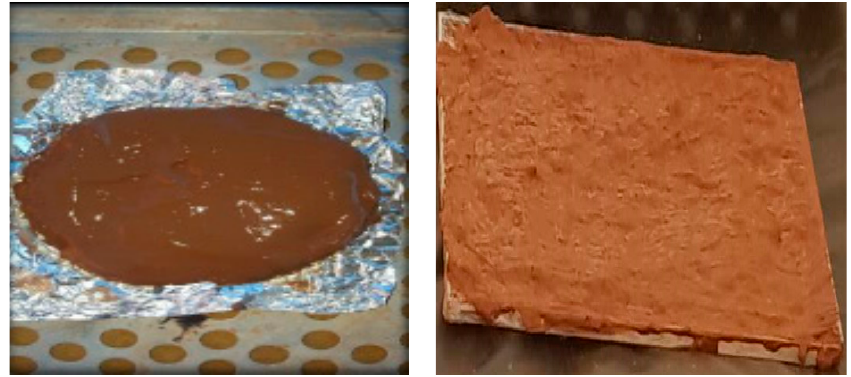
Figure 2. DWTS Sample.